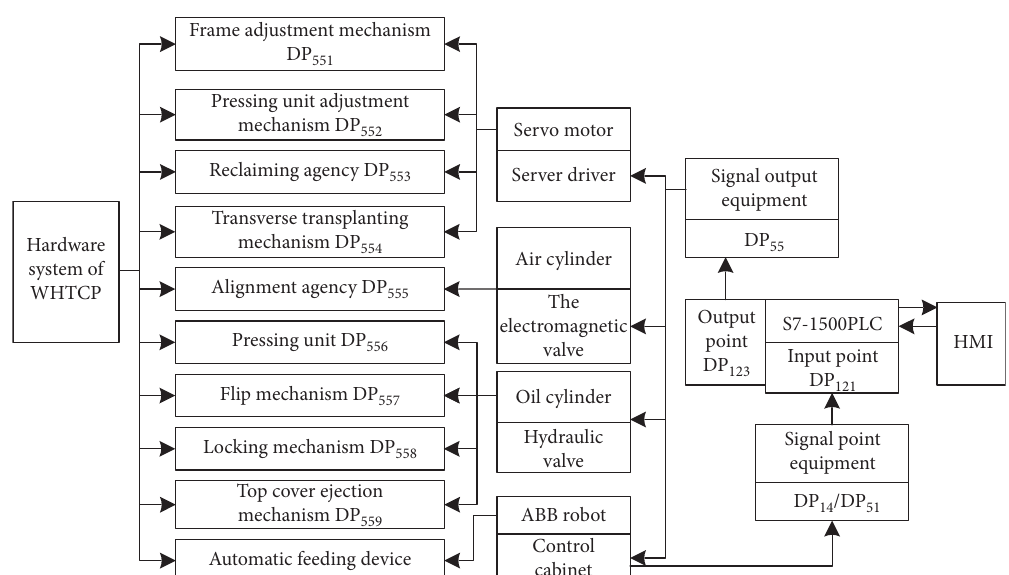
Figure 11: Hardware structure of the control service